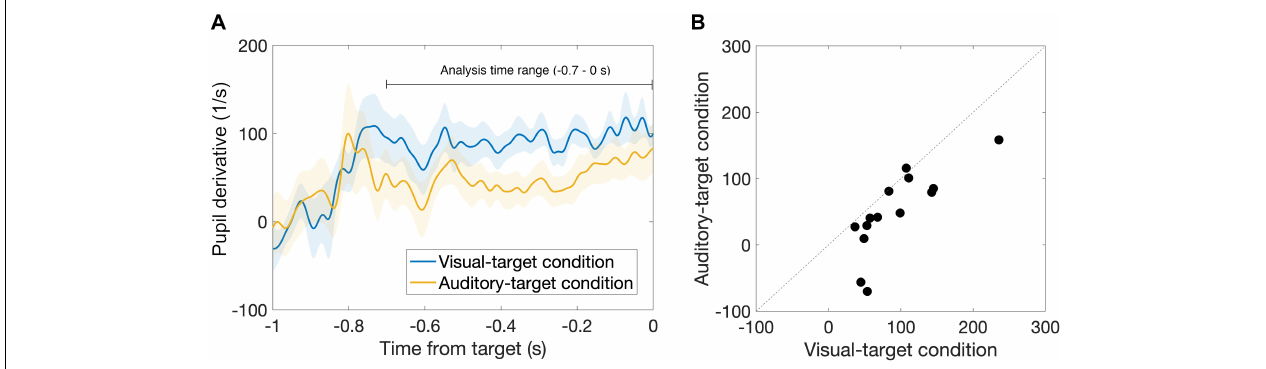
FIGURE 6 | (A) Comparison of time courses of pre-saccade pupil derivative between visual- and auditory-target conditions. (B) Comparison of pre-saccade pupil derivative averaged within − 0.7 to 0 s from target onset between visual- and auditory-target conditions. We found a significant difference between them, suggesting that, in contrast to absolute pupil size, pupil derivative is sensitive to the task set.